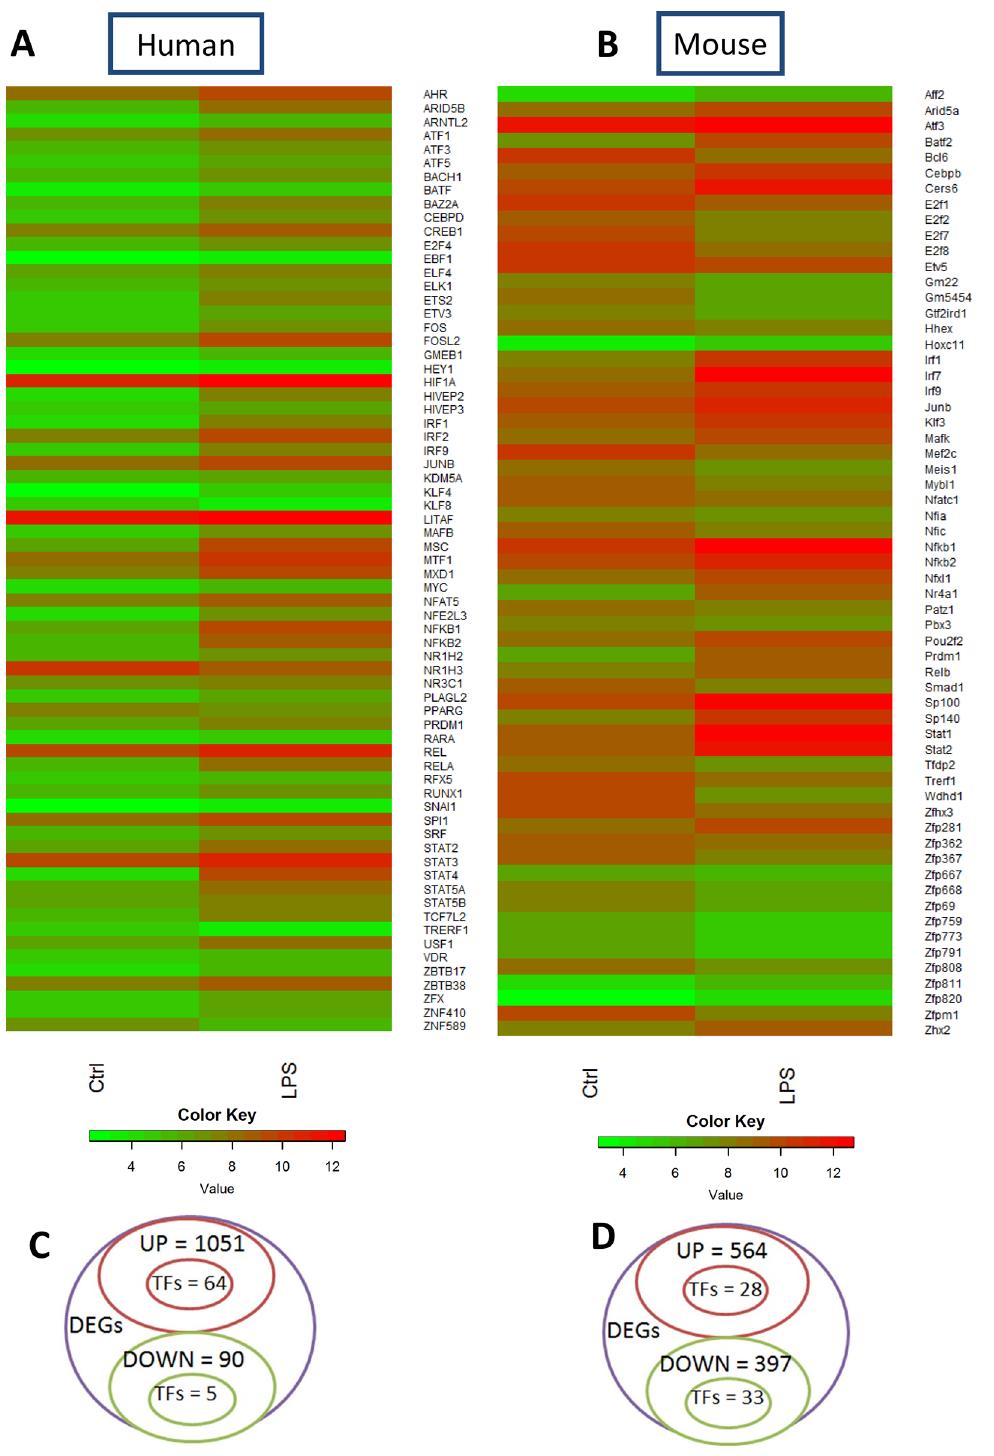
Fig 4. Heatmap of transcription factors and Venn diagrams of microarrays data. ( A, B ) Heatmaps of all the differentially expressed transcription factors (source: Animal TFDB) from ( A ) human and ( B ) mouse microarrays data. ( C, D ) Venn diagrams showing the number of differentially expressed genes and transcription factors under LPS stimulation in ( C ) human PBMCs-derived macrophages and ( D ) mouse RAW264.7 macrophages.